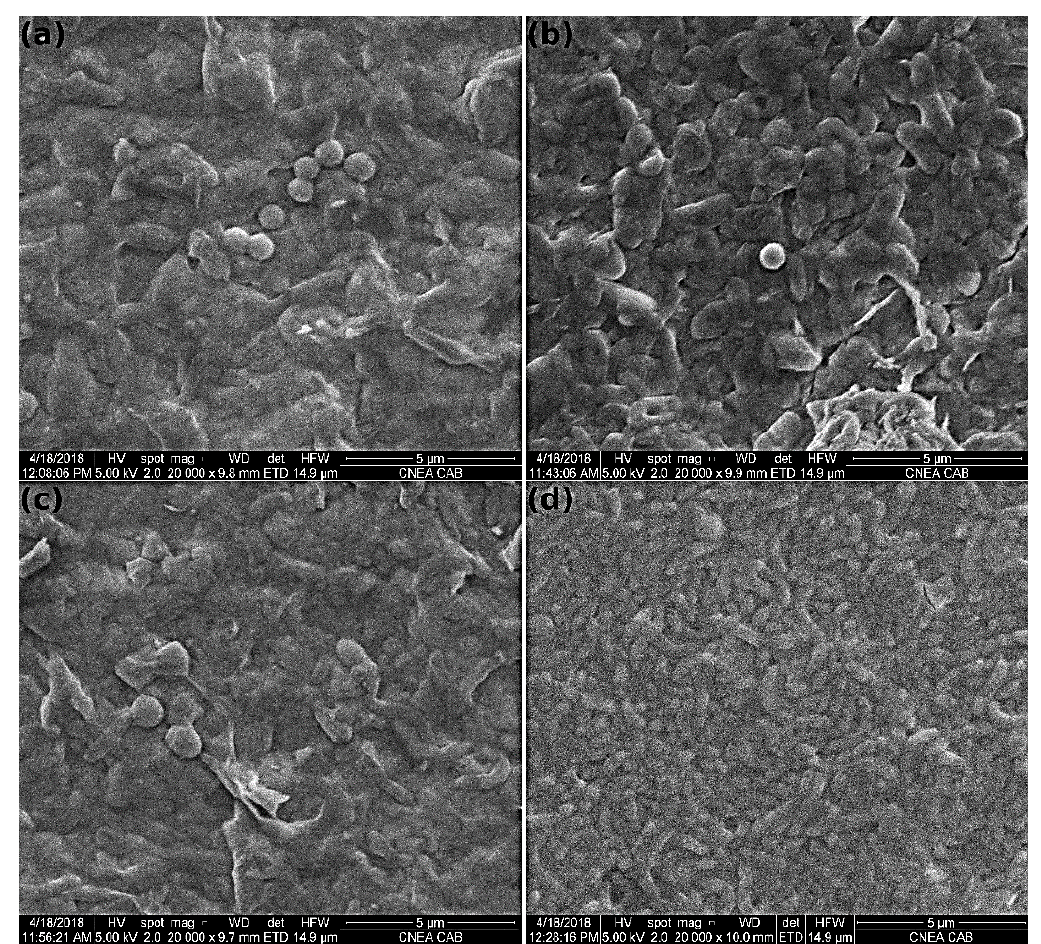
Figure 10. Scanning electron microscopy images taken after growth cycle II (eight days of culture) of biofilm formation on the different clays: ( a ) montmorillonite, ( b ) illite, ( c ) DR and ( d ) SF under sulfate-reducing anaerobic conditions.